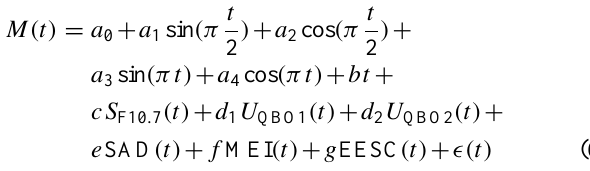
Fig. 4. Run mean, December–February mean differences compared to the reference run for auroral zone electrons (left), SPEs (center) and GCR (right) showing zonal wind (top, ms − 1 ), temperature (middle, K) and mass streamfunction (bottom, kgm − 1 s − 1 , values outside the ( − 4,4) interval not plotted). Solid and dashed contours denote regions with 95% and 90% confidence levels, respectively. These two contours are the same for all subsequent figures.